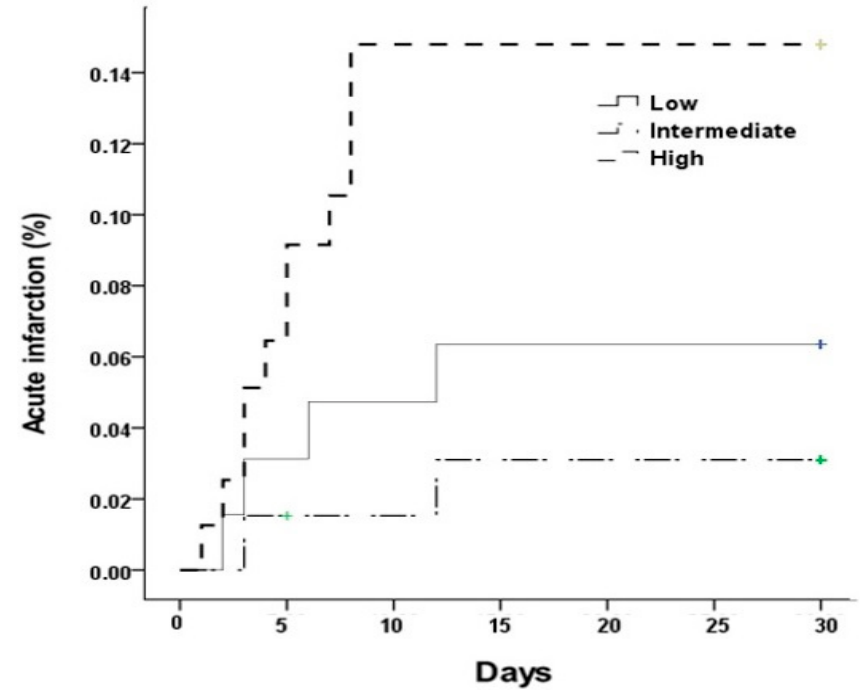
Figure 2. Kaplan–Meier event curves of acute cerebral infarction (Log rank 0.048).